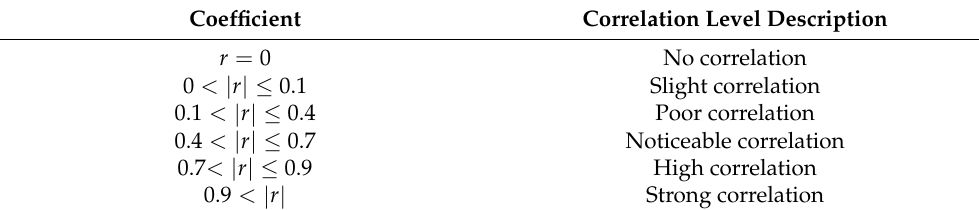
Table 1. Correlation level description based on correlation coefficient level